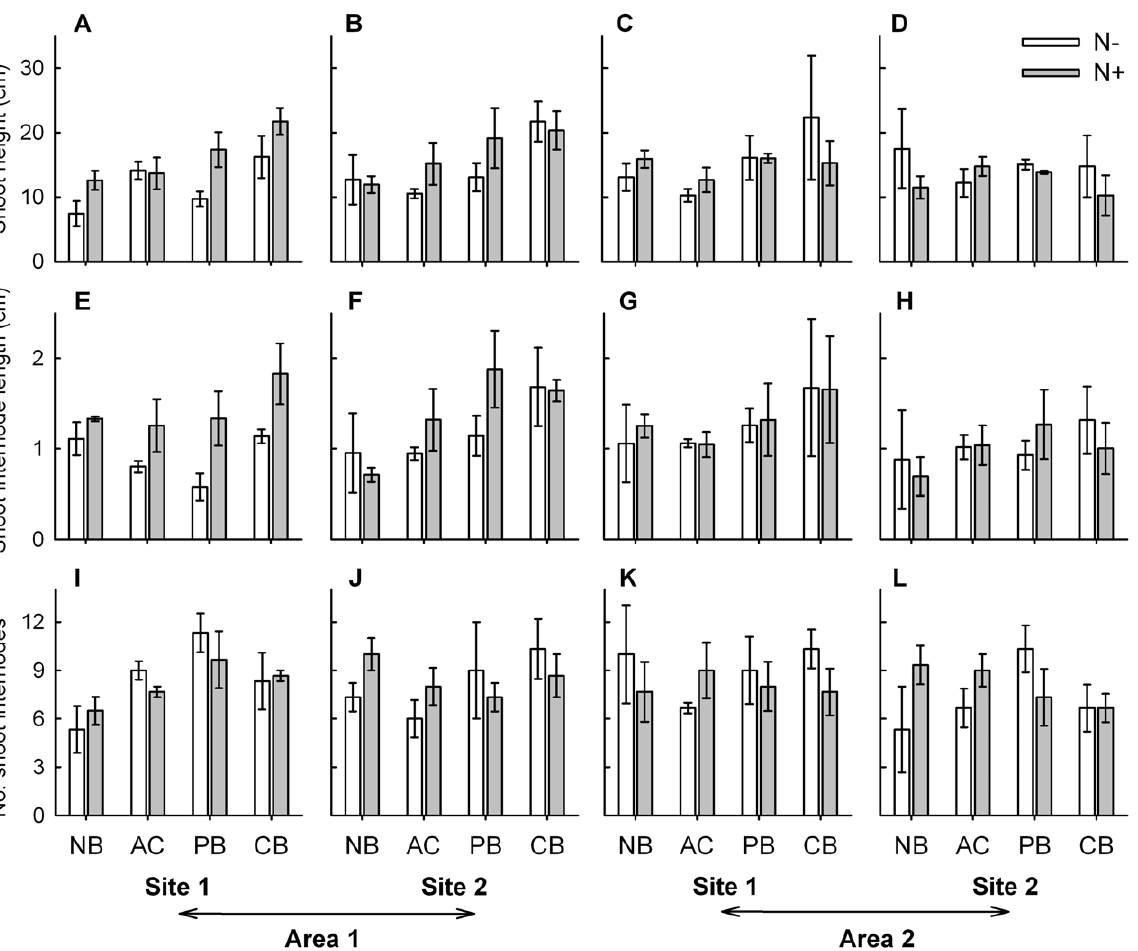
Figure 2. Morphological variables of Sporobolusvirginicus clones subjected to different experimental treatments. Mean ( 6 1 SE) maximum shoot length (A, B, C, D), shoot internode length (E, F, G, H) and number of shoot internodes (I, J, K, L) of plants grown in the two sites within each of the two areas. N 2 = no nutrient added, N + = nutrient addition; NB = no burial, AC = artifact control, PB = partial burial, CB = complete burial.